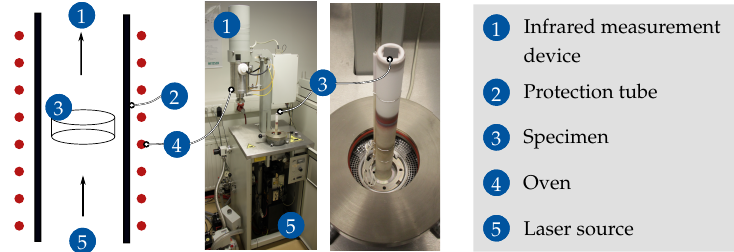
Figure 4. Measurement setup for the thermal diffusivity.